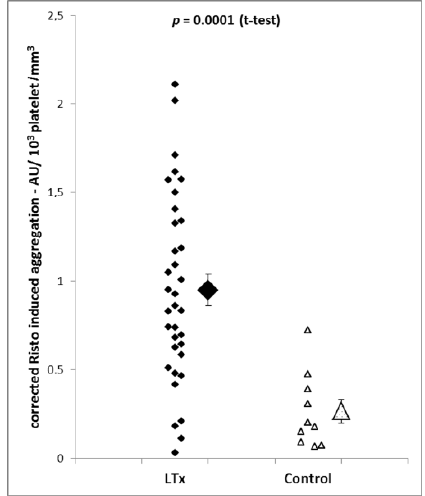
Figure 3. Ristocetin-induced aggregation after correction for platelet count is markedly higher in liver transplantation patients ( n = 35) than in control patients ( n = 10). Individual measurements as well as means and SEM of the groups are shown.